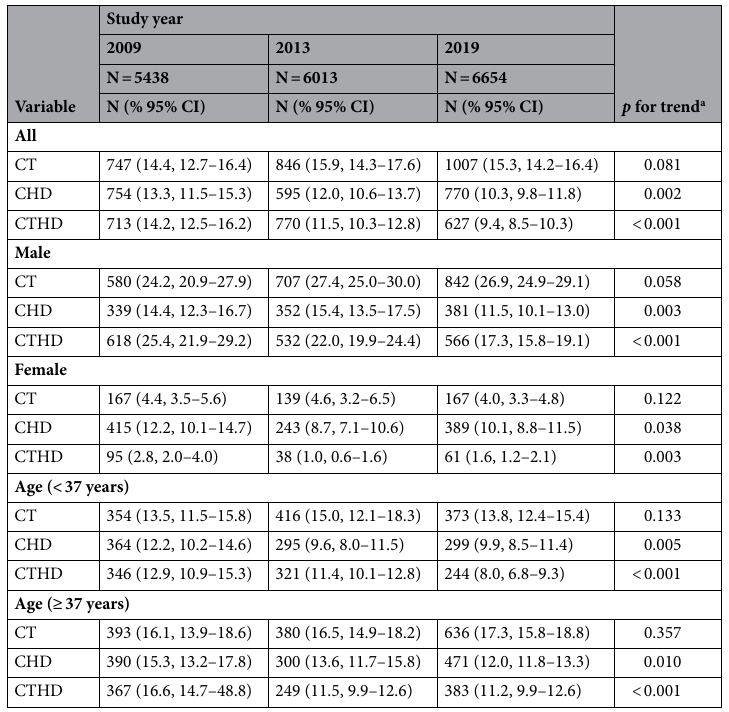
Table 3. Trends in the prevalence of current tobacco use only (= CT), current heavy drinking only (= CHD), current tobacco use and current heavy drinking (= CTHD) in the Mongolia STEPS survey, 2009–2019. a Trends were tested using multivariable logistic regression adjusted for sociodemographic and health